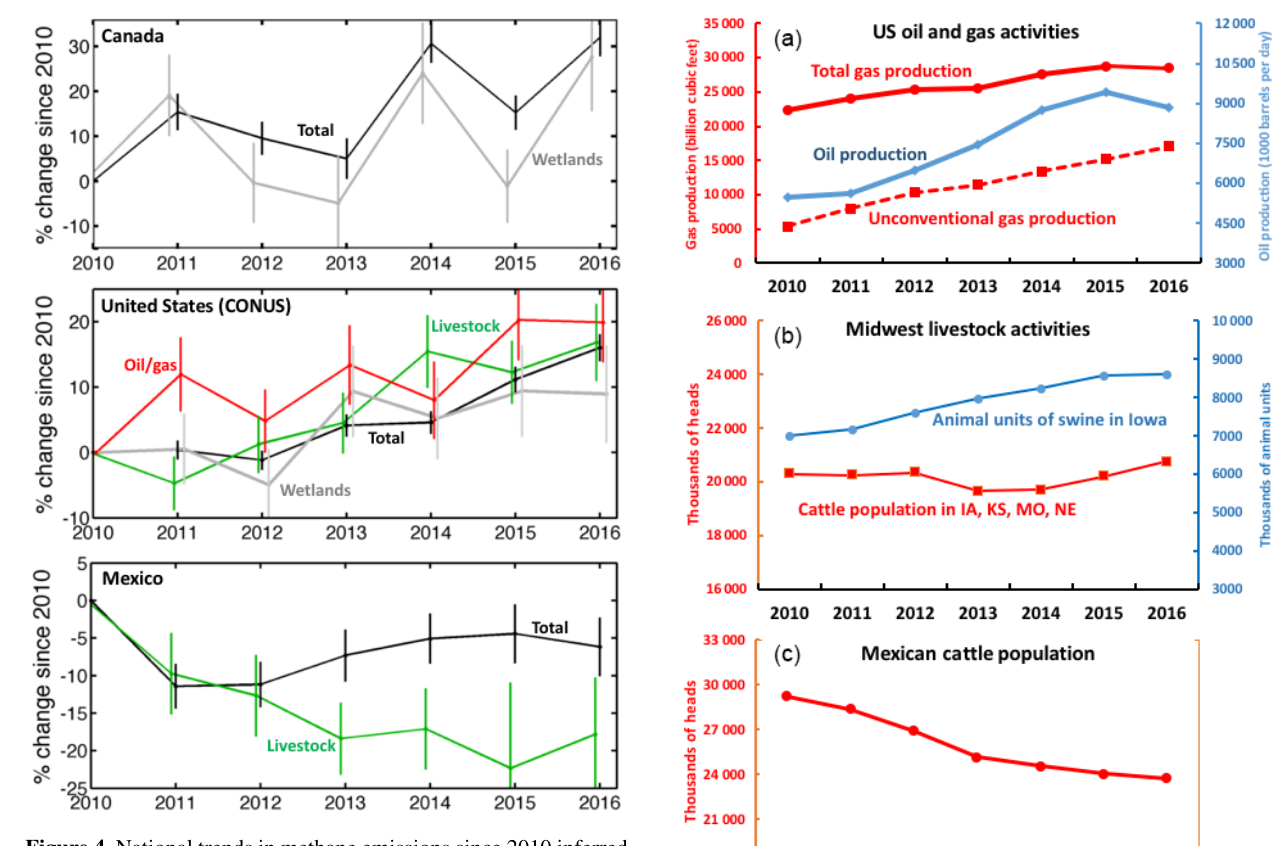
Figure 4. National trends in methane emissions since 2010 inferred from GOSAT, and contributions from specific source sectors where sufficient data are available. The trends are defined by relative year- to-year changes in the summed methane enhancements (cid:49) relative to the local backgrounds as computed from Eq. (1), and vertical bars are standard deviations derived from uncertainty in the local background (see text).